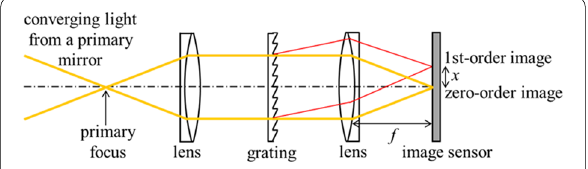
Fig. 1 A standard configuration to use gratings for spectral cameras. First, parallel light rays enter the flat surface of the grating. Then, parallel rays after the grooved surface of the grating are focused on the image